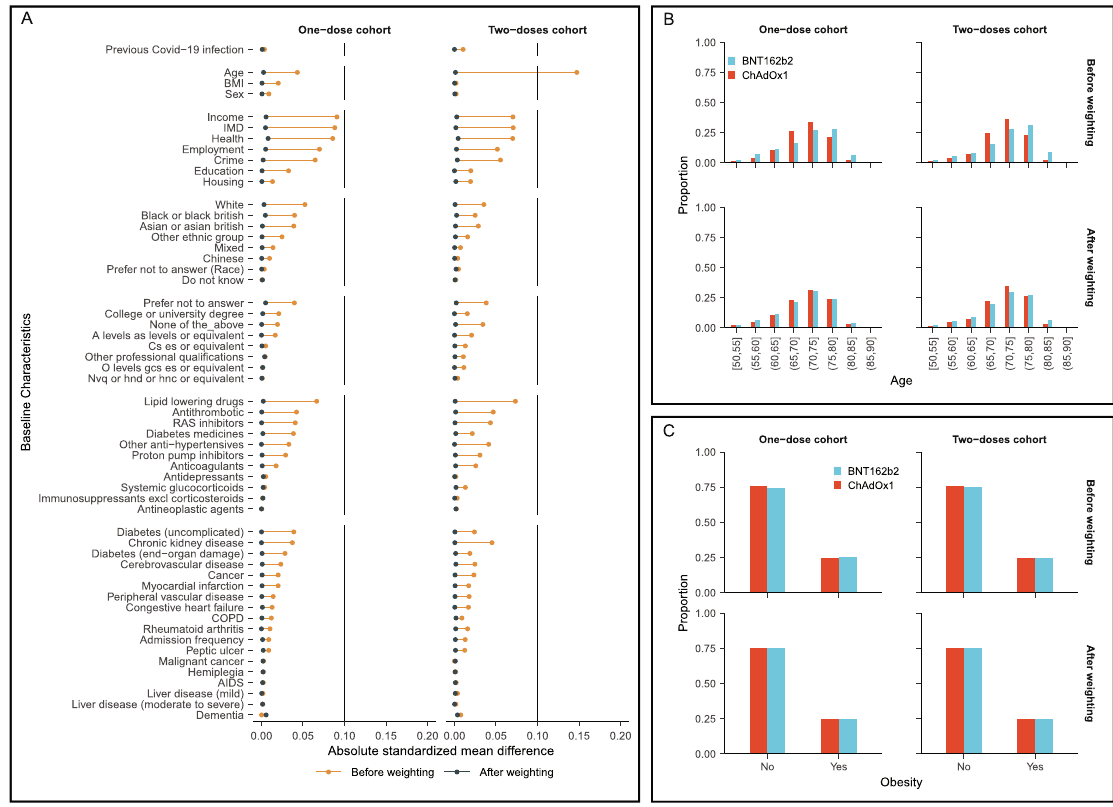
Fig. 2 Balance of baseline covariates for the one dose and two doses cohorts, before and after weighting. A The standardized mean difference for all covariates included in the propensity score. B , C The proportion of age categories and obesity by vaccine types. NATURE COMMUNICATIONS| (2022) 13:1519